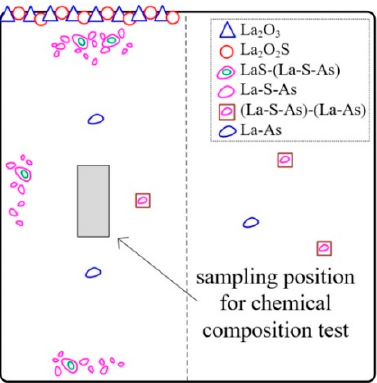
Figure 7. Distribution of inclusions at the profile of the ingot.